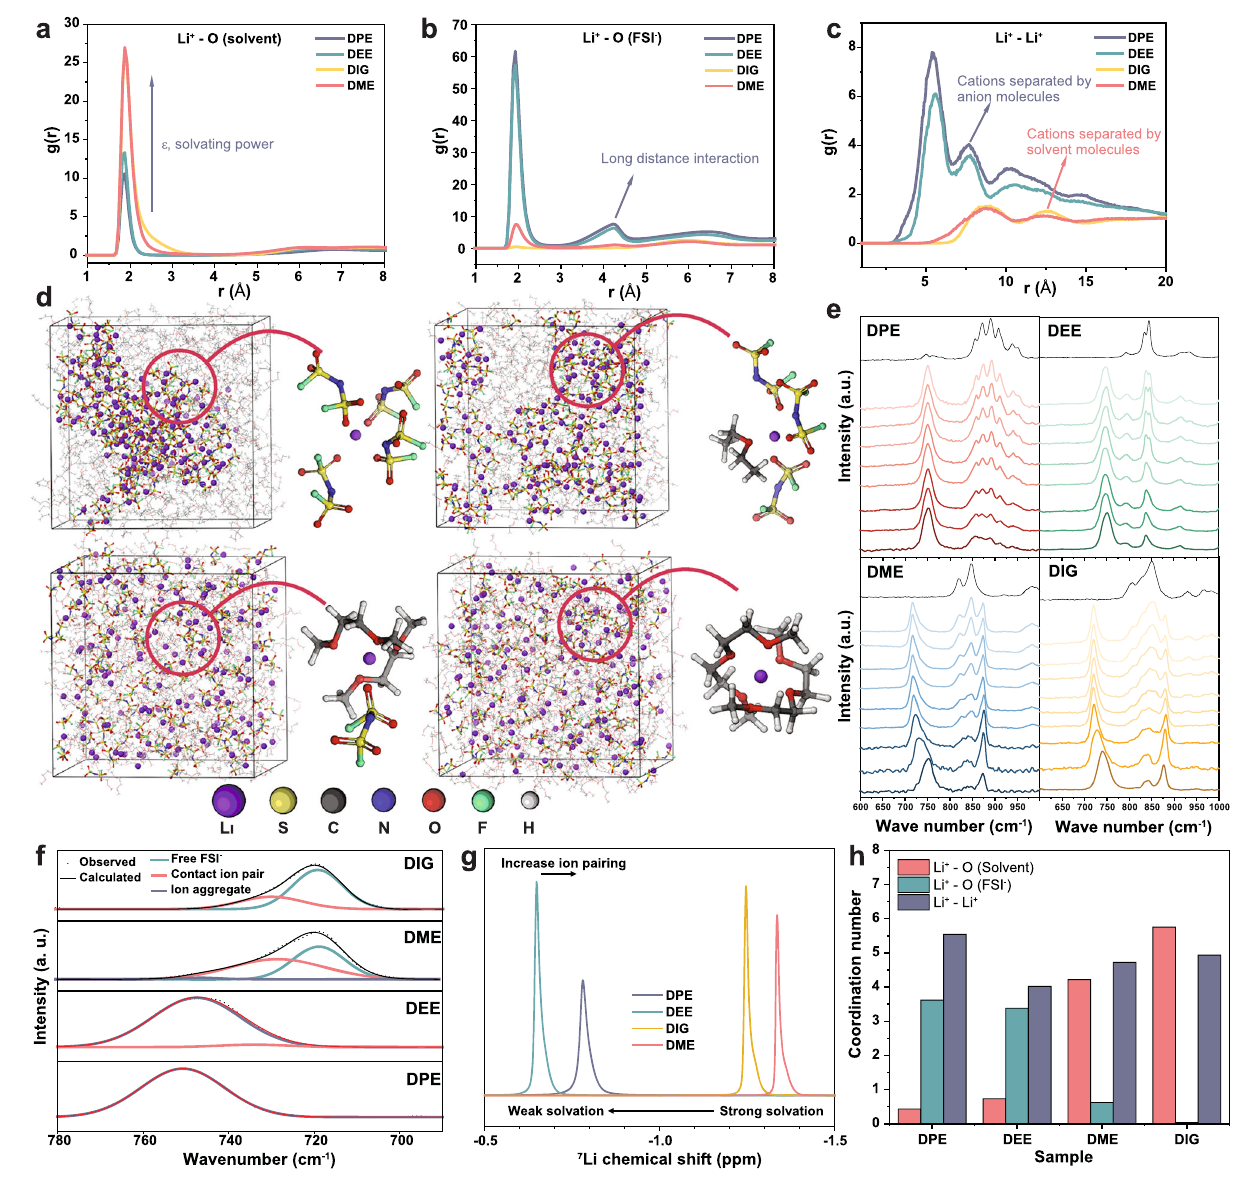
Fig. 2 | Investigations on the solvation environment of the ether-based elec- trolyte solutions. Radial distribution functions of interactions between Li + to solvent( a ),Li + toFSI − ( b ),andLi + toLi + ( c ). d SnapshotsoftheMDsimulationboxes of the four 1.8M LiFSI electrolytes at 25°C. e Concentration-dependent Raman